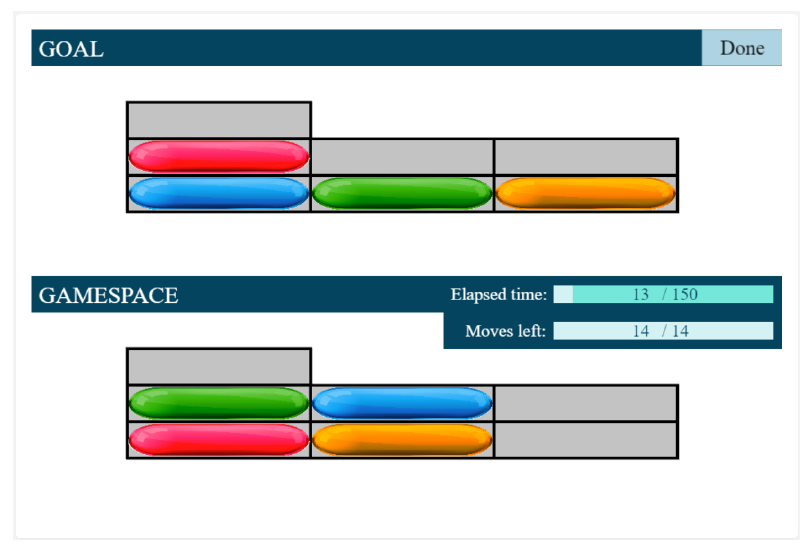
Figure 3. Screenshot of the gamespace during the Tower of London